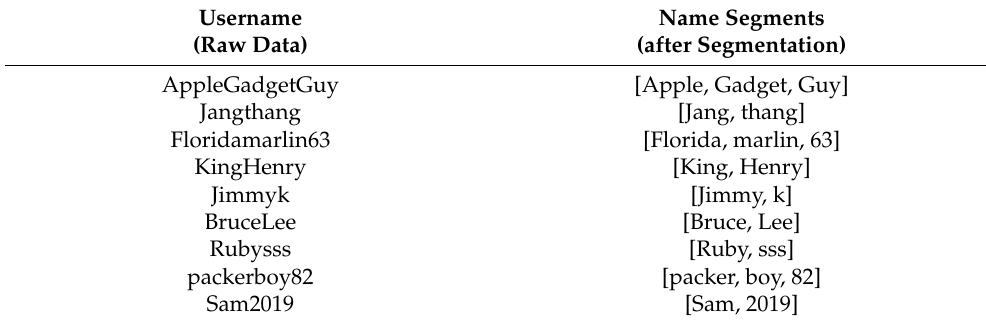
Table 3. A sample of usernames and the produced list of names after